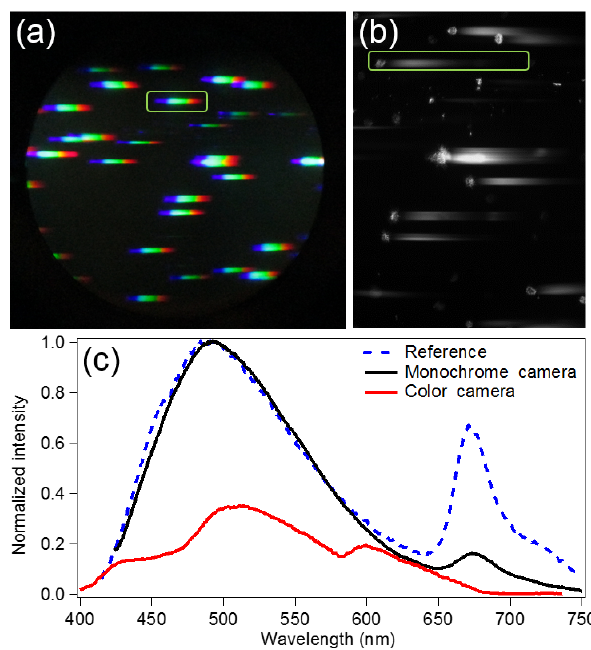
Figure 6. Spectral images and associated spectra for individual par- ticles of Kentucky bluegrass ( Poa pratensis ) pollen. Both images show fluorescence of particles illuminated by 405nm diode laser and utilizing 420nm long-pass blocking filter. (a) Color camera de- tection. (b) Black-and-white camera detection. (c) Spectra of one particle from each image (boxed particle from a, b shown). Ref- erence spectrum (dashed line) from microplate reader spectrofluo- rometer showing bulk average of ∼ 5mg of material. Spectra from monochrome camera and reference technique normalized to peak height of 1.0. Spectrum from color camera arbitrarily scaled to show reduced intensity of collection compared to monochrome